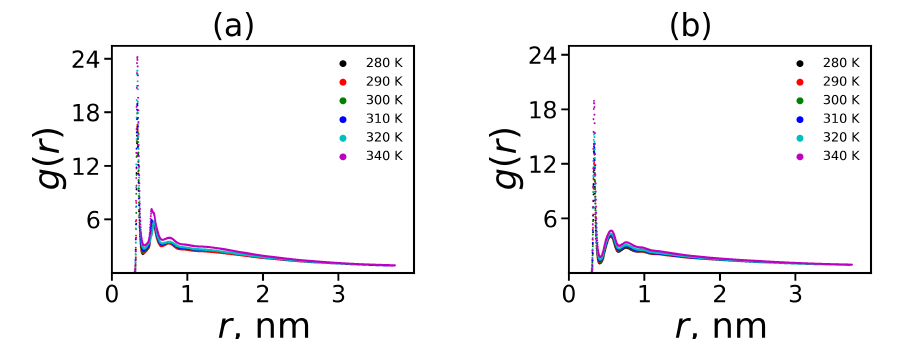
Figure 6. The ion pairs radial distribution function at different temperatures between ( a ) ions and the side charged groups; ( b ) ions and the terminal charged groups.